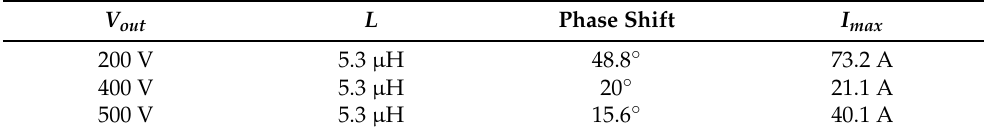
Table 3. φ and I max values for L = 5.3 µ H and P out = 7.5 kW. V